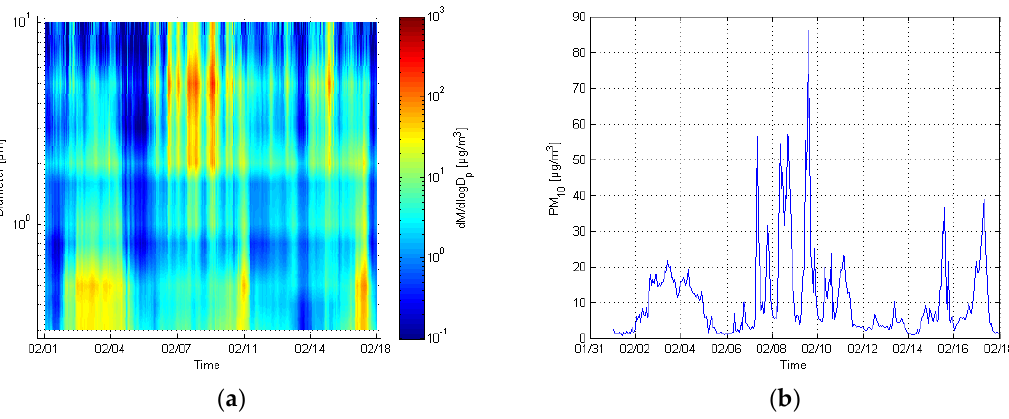
Figure 9. Normalized mass distribution of the GRIMM ( a ) and respective PM 10 values ( b ).